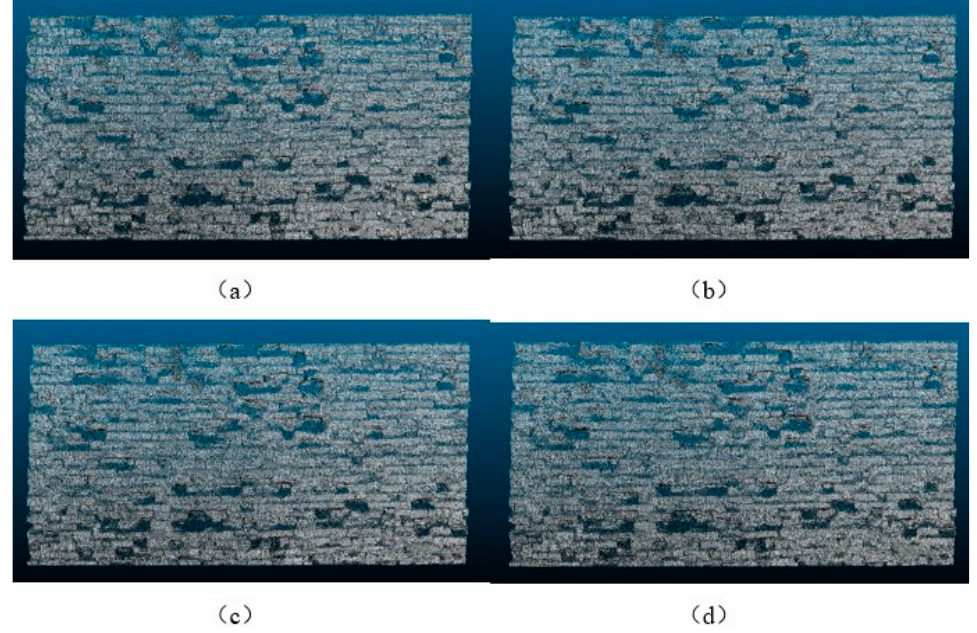
Figure 19. Point cloud marked by Normal Vector. ( a ) K = 4. ( b ) K = 6. ( c ) K = 8. ( d ) K = 10.